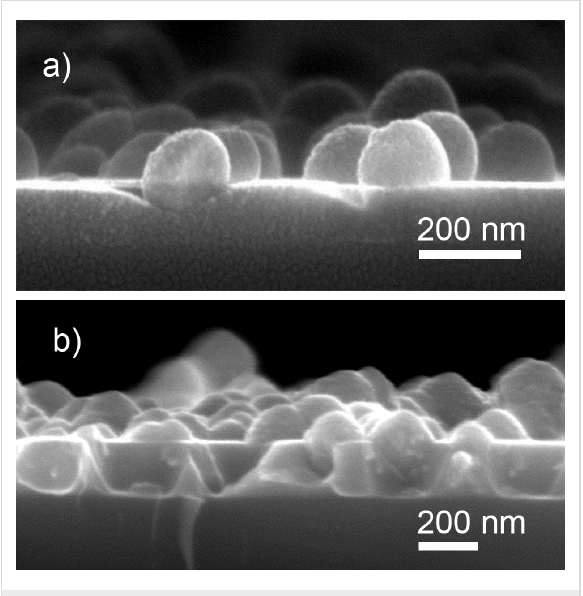
Figure 14: C/H NPs prepared in GAS by plasma polymerization of n -hexane and overcoated a) with a thin film of C/H plasma polymer (reprinted from [76], with permission from Elsevier) and b) with a Ti thin film (obtained in a similar manner as in [77]).